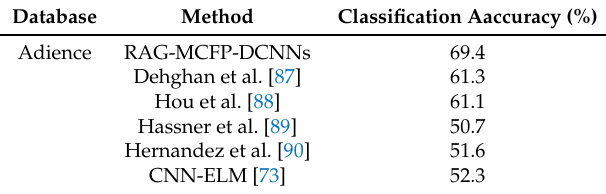
Table 7. Comparative experiments on age classification using Adience database.